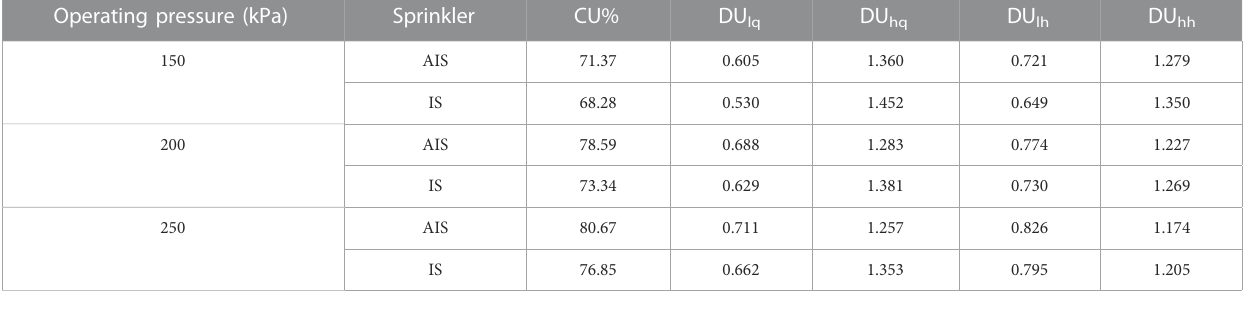
TABLE 2 Results of water uniformity coef fi cients with a 1R combination spacing coef fi cient. Operating pressure (kPa)